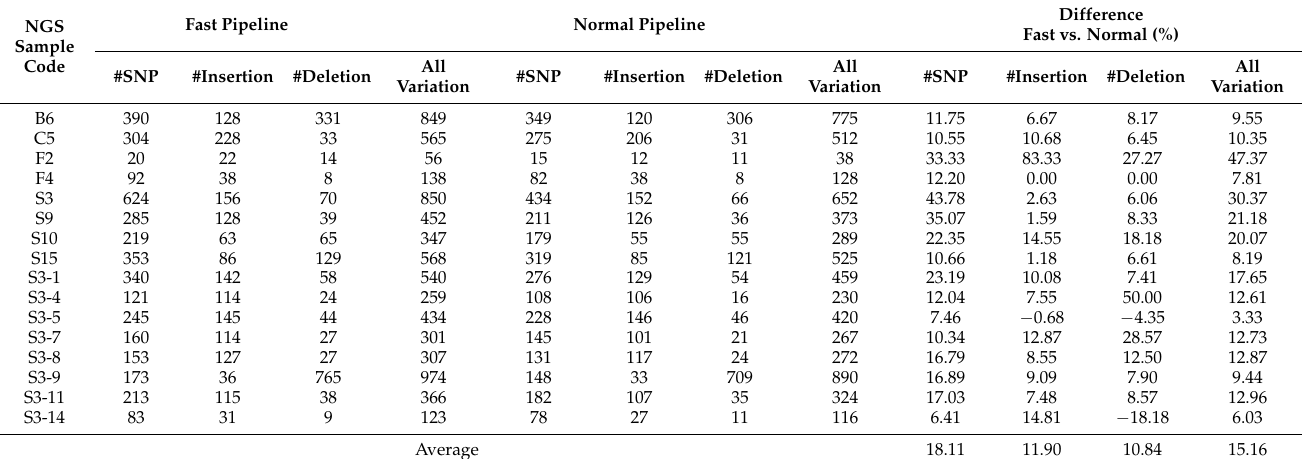
Table 7. Statistics Summary of Variation (SNP, Insertion, and Deletion) Detected in All Samples Implemented in Both